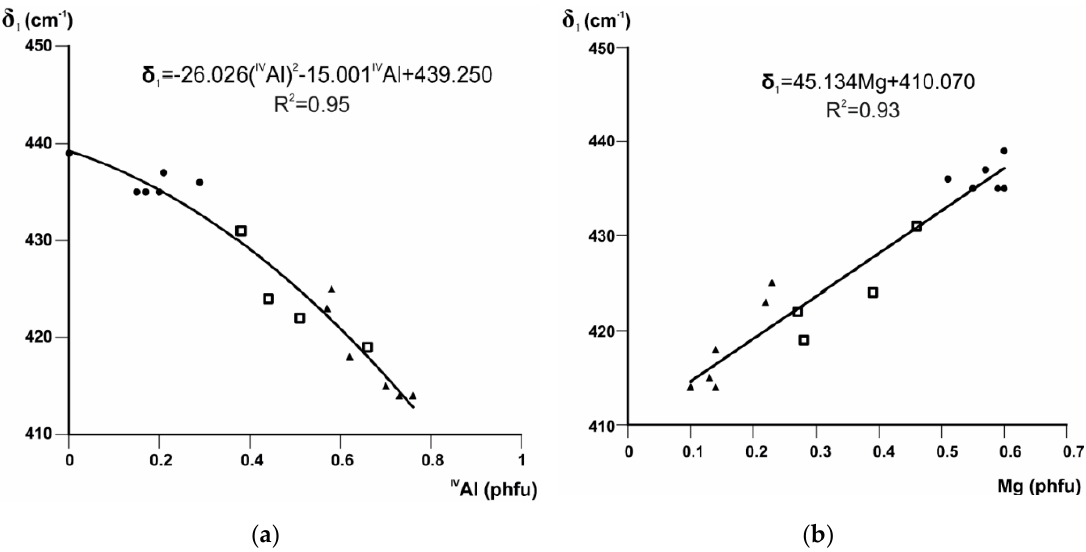
Figure 2. Band positions (cm − 1 ) of δ 1 in Fe ‐ poor K ‐ dioctahedral 1 M micas plotted vs . ( a ) IV Al and ( b ) Mg contents (cations p.h.f.u. ). Symbols: triangle = (Mg,Fe) ‐ poor illites, square = Mg ‐ rich illites, circle = aluminoceladonites.